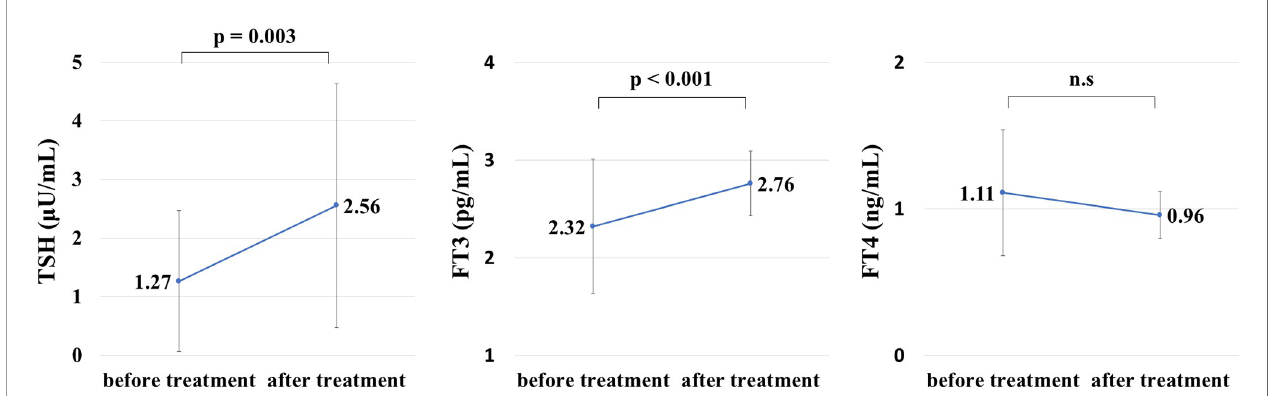
FIGURE 1 | Thyroid hormone levels before and after treatment for hyperglycemia during hospitalization. Thyroid hormone levels after treatment for hyperglycemia were measured on a mean of 13.2 days after admission. Thyroid-stimulating hormone (TSH) and free thyroxine (FT3) levels were signi fi cantly improved after